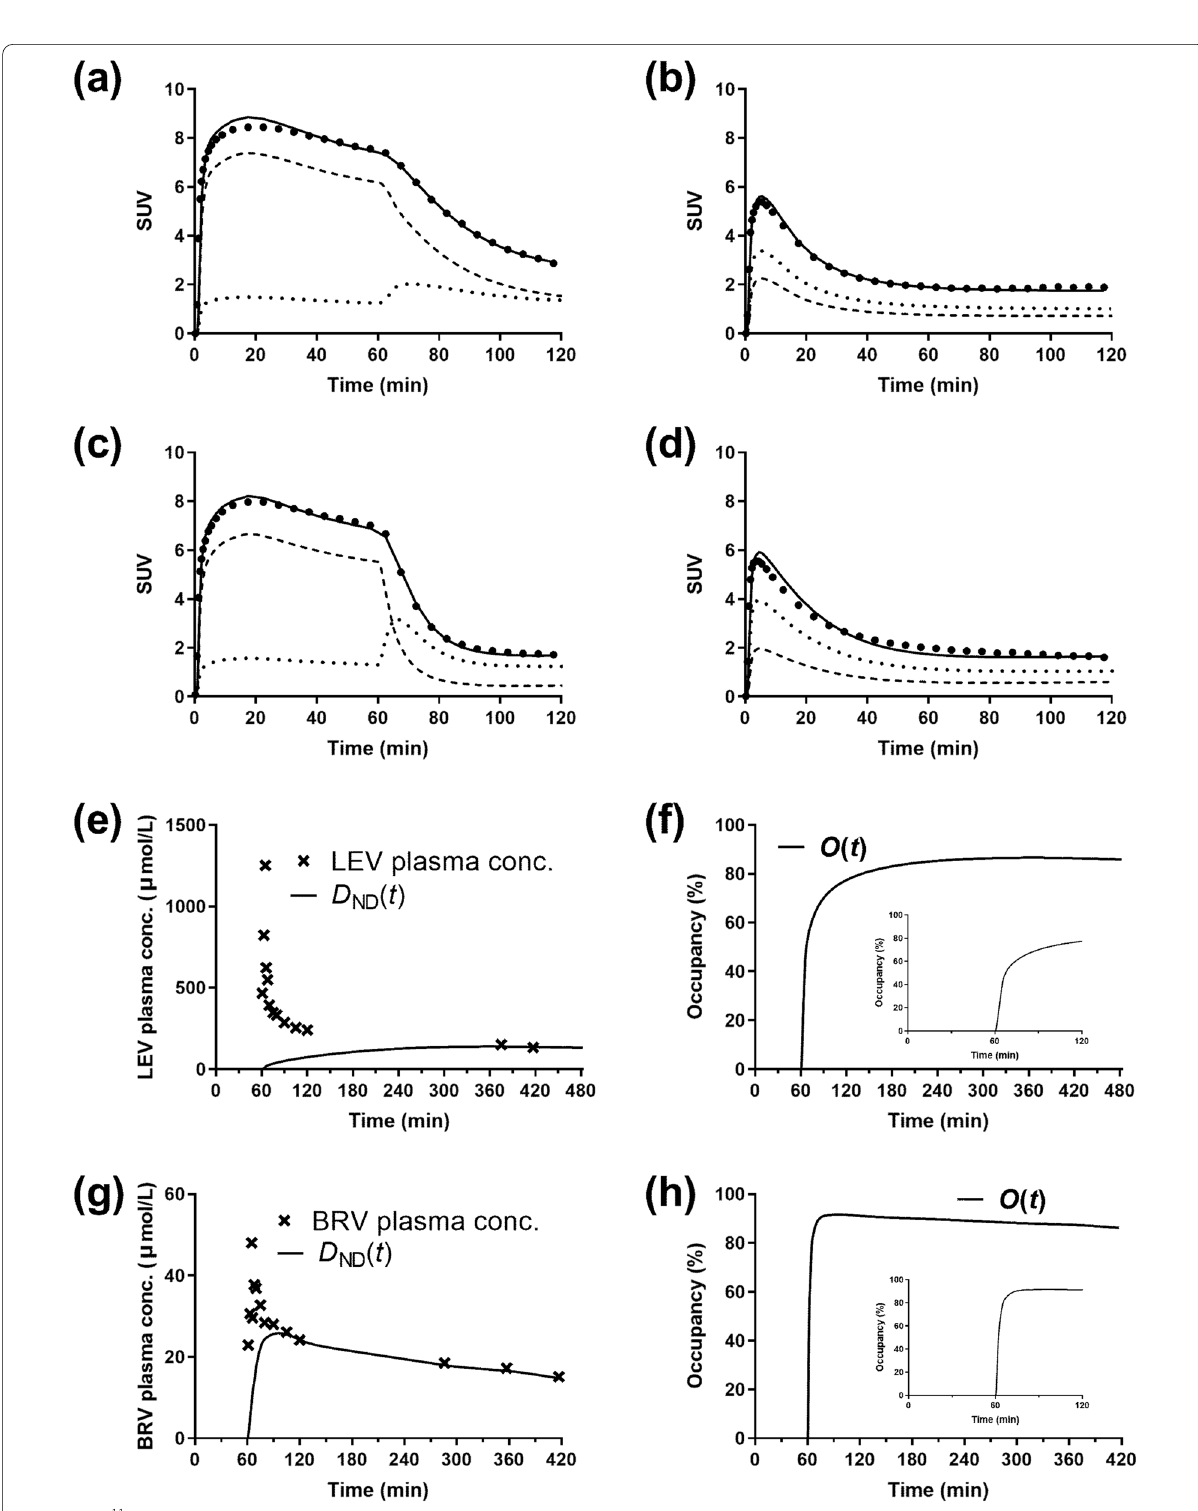
Fig. 2 a – d 11 C‑UCB‑J activity curves in the frontal cortex (closed circles) with model fits (solid curves). a and b Displacement (LEV, 1500 mg at 60 min) and post‑dose scans, c and d displacement (BRV, 200 mg at 60 min) and post‑dose scans. C ND ( t ) and C S ( t ) are displayed in the dotted and dashed curves, respectively. e – h Concentrations of AED in the plasma and non‑displaceable AED in the frontal cortex ( D ND ( t )) and occupancy curves ( O ( t )) by LEV ( e , f ) and BRV ( g , h ). Insets in f and h show the occupancy curves for the first 2